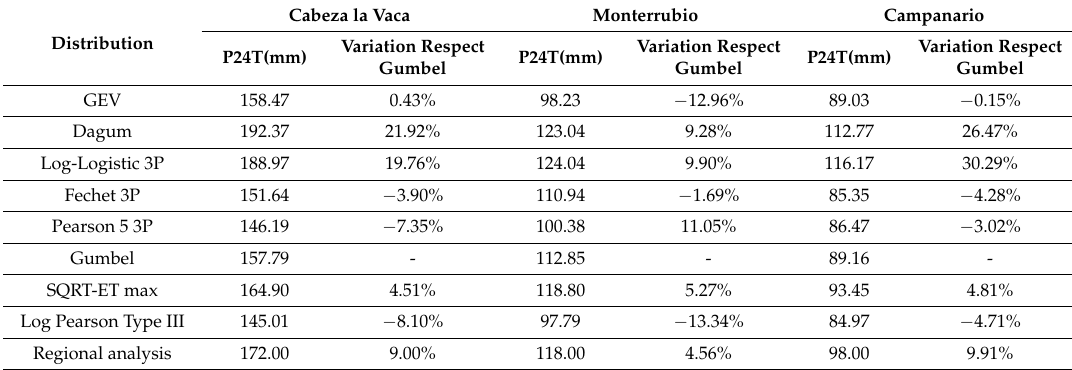
Table 3. Maximum daily precipitation for different